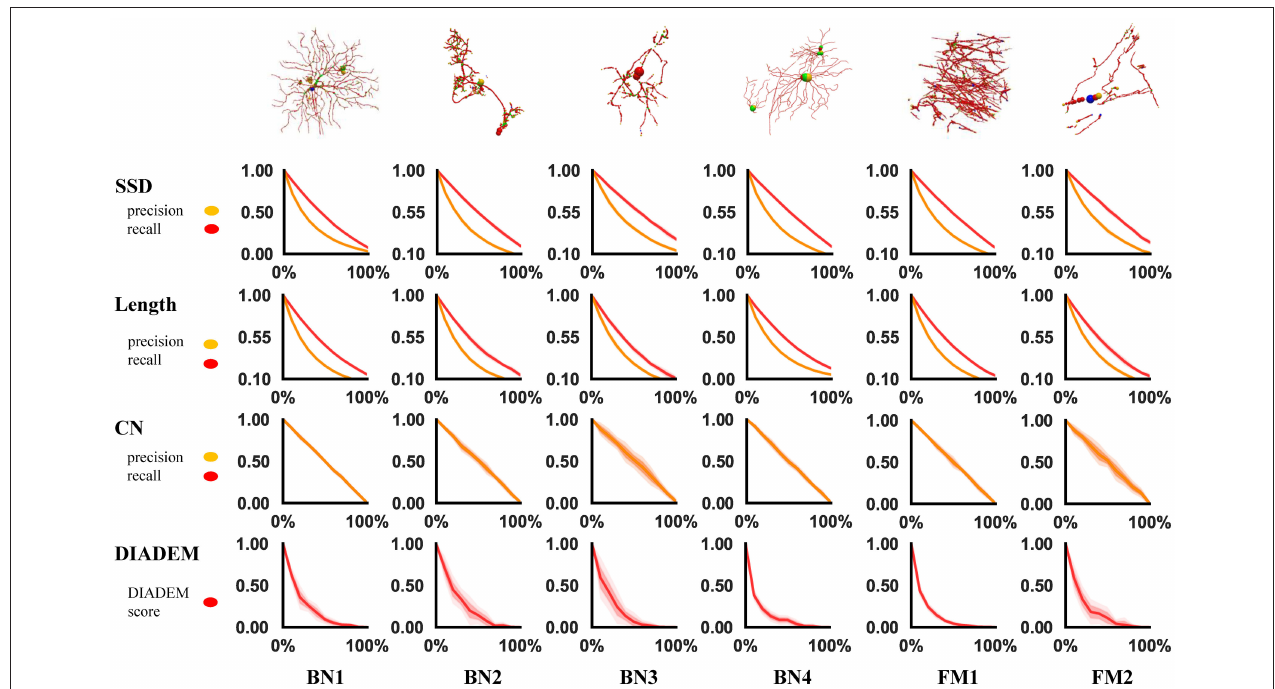
FIGURE 2 | Result of robustness test. Each row represents a metric and each column represents an swc model. In each chart, the x-axis is the perturbed proportion and the y-axis is the corresponding metric